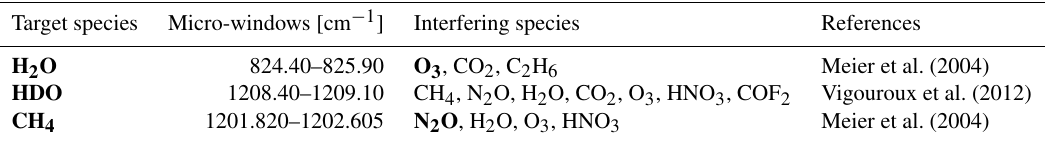
Table 2. Windows used for the pre-retrievals of H 2 O, HDO, and CH 4 . Profile-retrieved species are in bold. Target